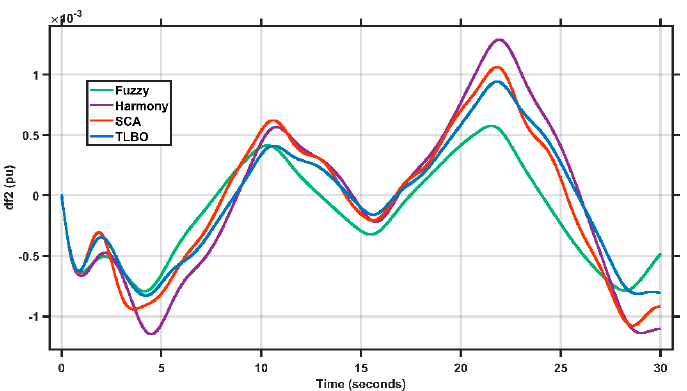
Figure 22. Change in area 2 frequency under wave disturbance.